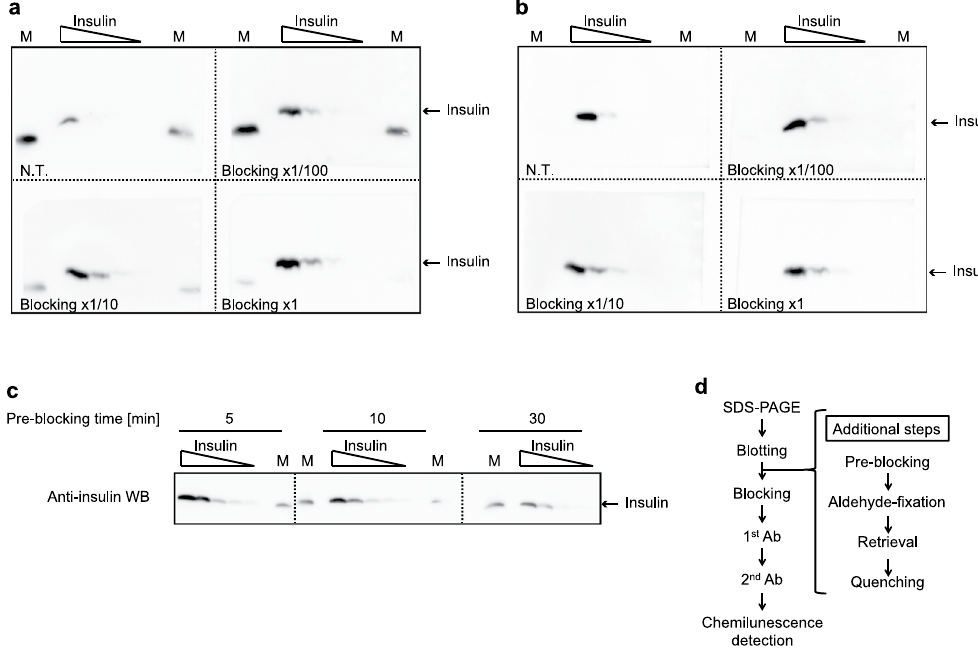
Figure 4. Treatment of blocking buffer in pre-fixed blots enhances the improvement of WB signals from insulin. ( a,b ) Dilution series (panel a for low doses: 10, 3, 1, 0.3 ng and panel b for high doses: 100, 30, 10, 3 ng) of insulin were subjected to Tris/Tricine/urea SDS-PAGE. M indicates molecular weight markers. For concentration evaluation, 4 slips from the one blotted membrane were treated with the indicated concentration of blocking solution. ( c ) For time optimization, the dilution series (10, 3, 1, 0.3, 0.1 ng) of insulin were subjected to Tris/Tricine/urea SDS-PAGE. Three slips from the one blotted membrane were treated with the 1x blocking solution for the indicated time. M indicates a lane for molecular weight markers. One of the containing proteins cross-reacts with anti-insulin antibodies. ( d ) Flow diagram of the improved proinsulin/insulin WB. To compare the effects of the various conditions, WB images in each sub-part of the figure were captured at one